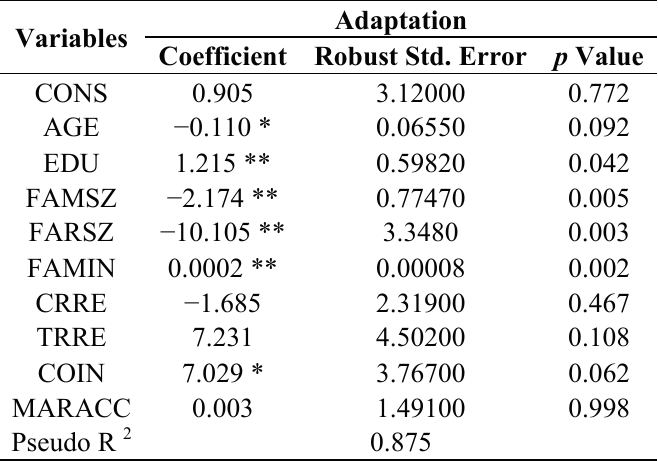
* Weak co-linearity between the two variables ** High co-linearity between the two variables. Table 5. Estimates of binary logit regression model based on farmers’ adaptation strategies to climate change